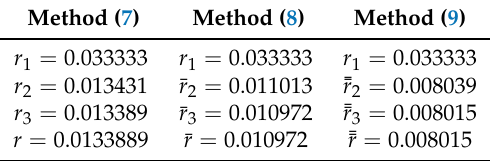
Table 2. Numerical results for Example 2.